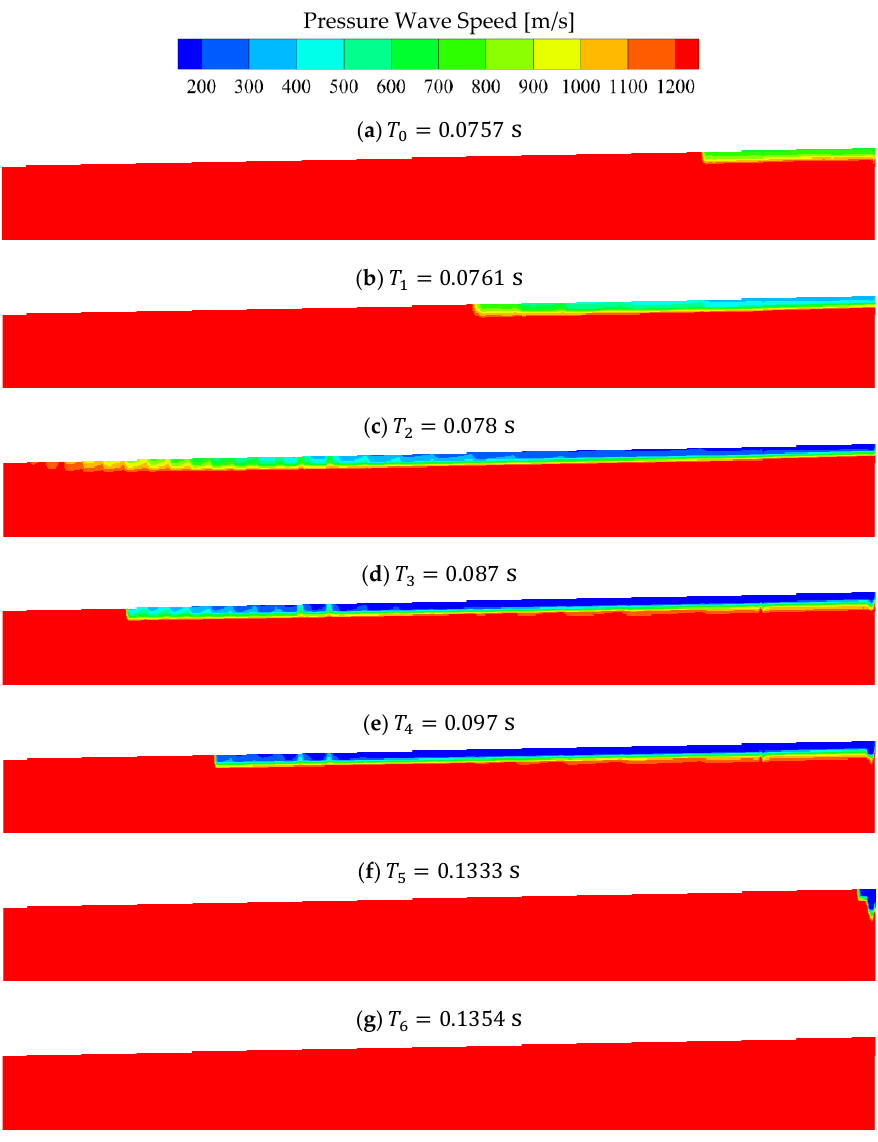
Figure 36. Pressure wave speed field evolution in the transient cavitation flow.